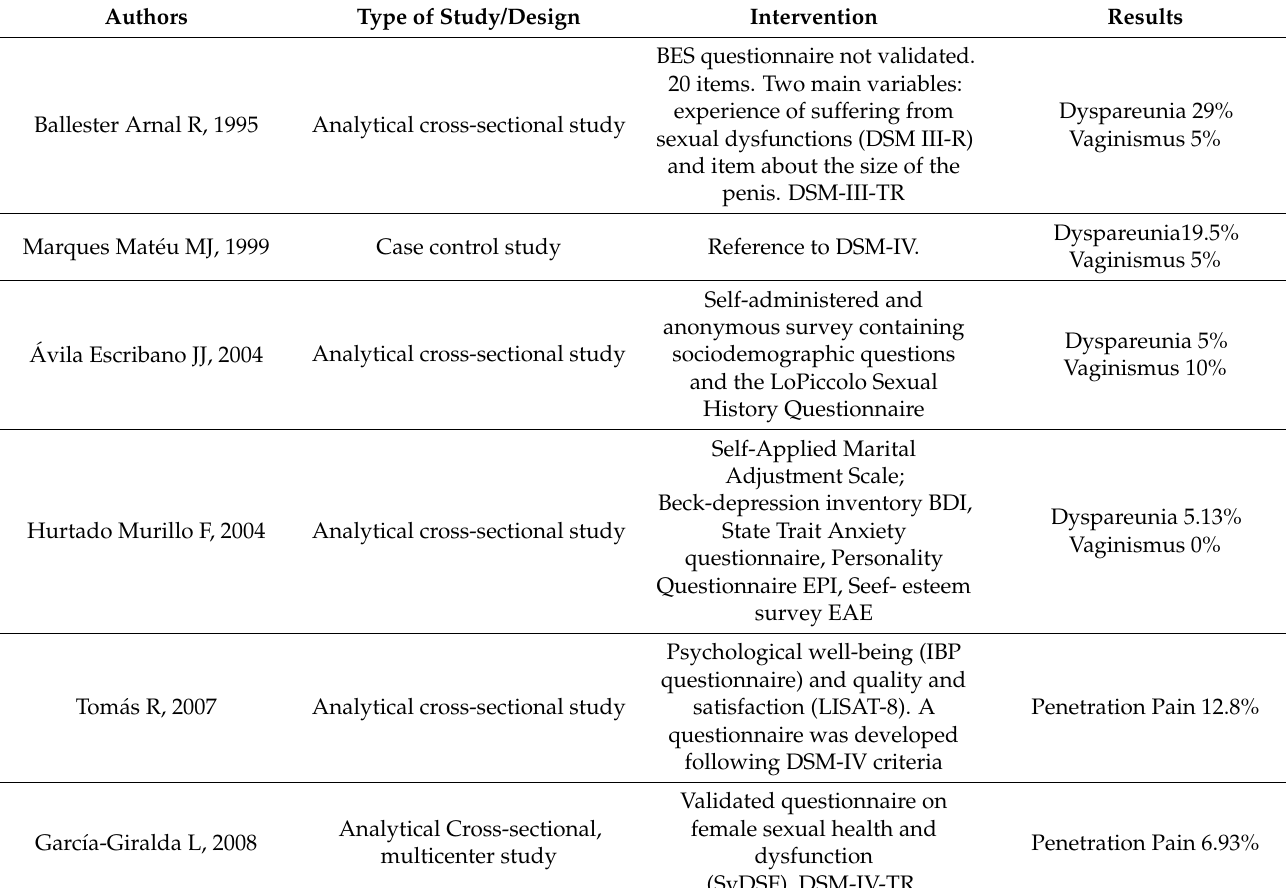
Figure 3. Forest plot of the pooled analysis for the random-effects model. Table 3. Studies (n = 11) meeting inclusion criteria of final analysis. Descriptive data, GPPPD specifically referred as penetration pain, dyspareunia, vaginismus; expressed as a